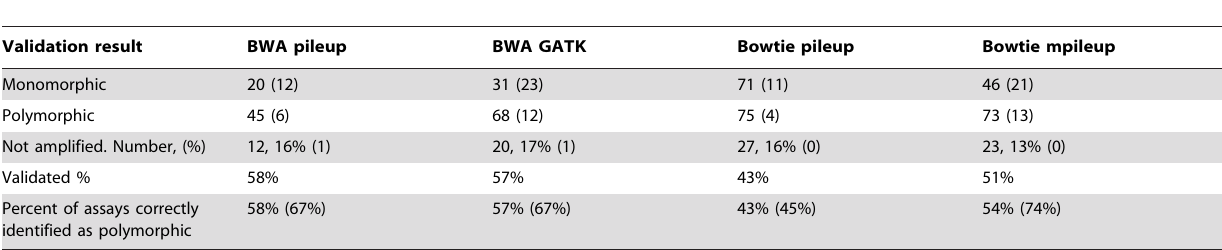
Table 2. Counts of SNP that converted to successful assays predicted by different pipelines.